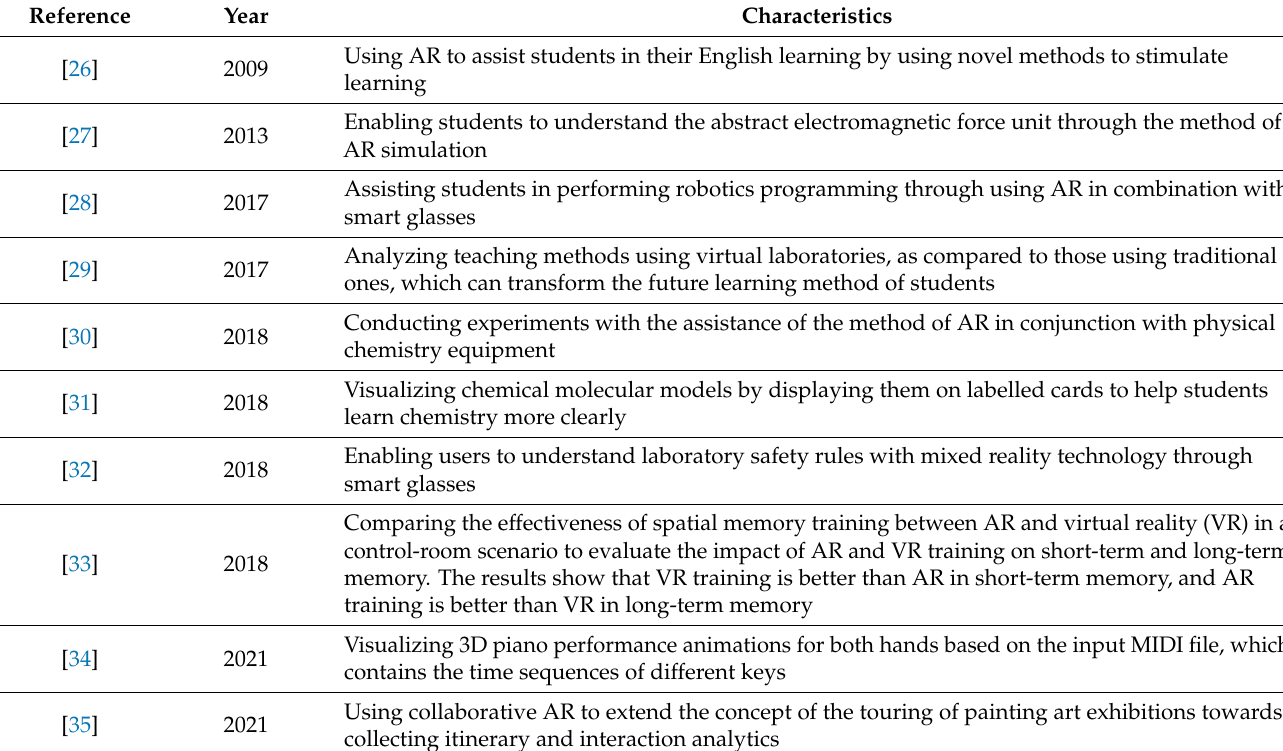
Table 2. Examples of application of AR to different educational